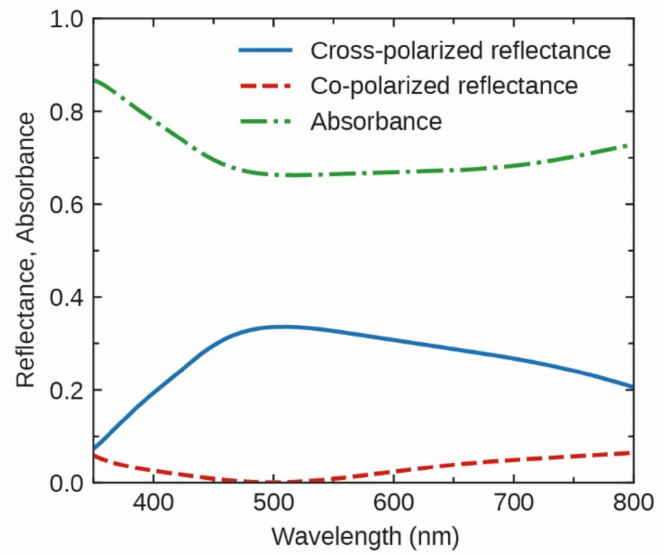
Figure A2. Cross- and co-polarized reflectance amplitudes ( R cross , R co ) and absorbance A of the Bi 2 Te 3 nanobrick metasurface used in Figure 3a with a 170 nm length, 45 nm width, 45 nm height, 200 nm pitch, and 50 nm SiO 2 spacer layer. Since the transmittance was equal to zero, the absorbance was calculated using A = 1 − R = 1 − R cross − R co